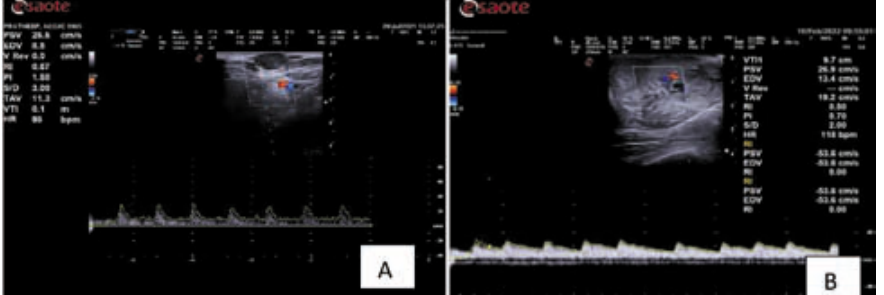
Fig.4. Spectral Doppler ultrasonographic image of mass with tumour neovascularisation and blood flow velocity waveforms in (a) A benign mammary neoplasm (B) A malignant mammary